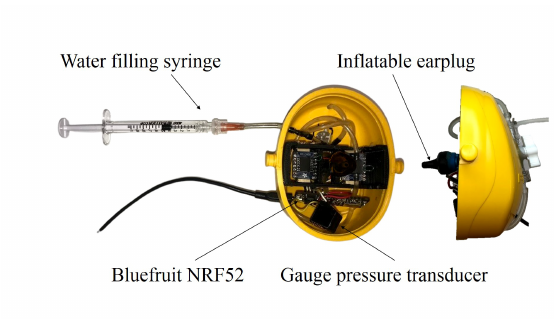
Figure 1. In-ear power sensor: inflatable earplug and associated hydraulic circuit in the right cup. The left cup is equipped with an earphone with two miniature microphones: In-Ear Microphone (IEM) and Outer Ear Microphone (OEM) as shown in Figure 2. The earphone is fitted into the earcanal using a generic foam earpiece called EARTIP (Comply, Oakdale, MN, USA).